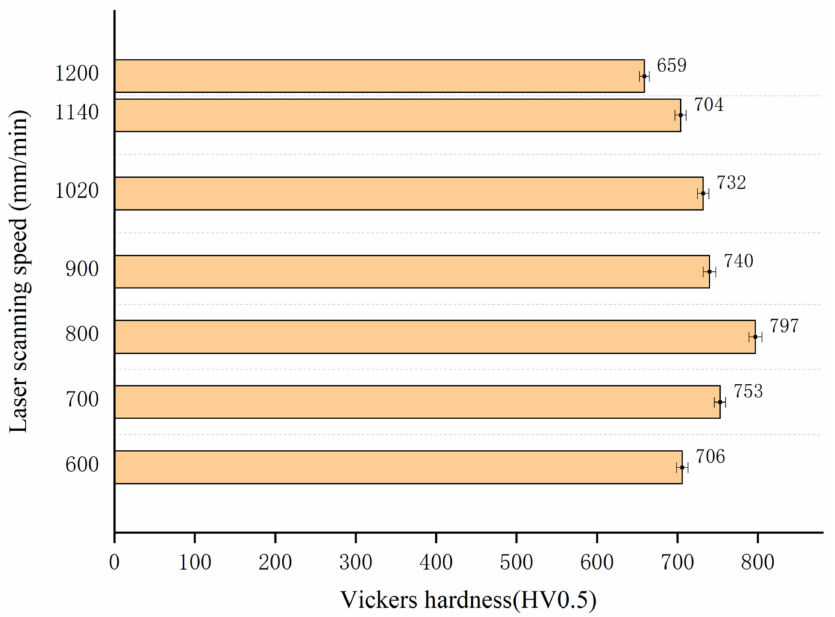
Figure 3. The relationship between the laser scanning speed and the surface Vickers hardness of the hardened